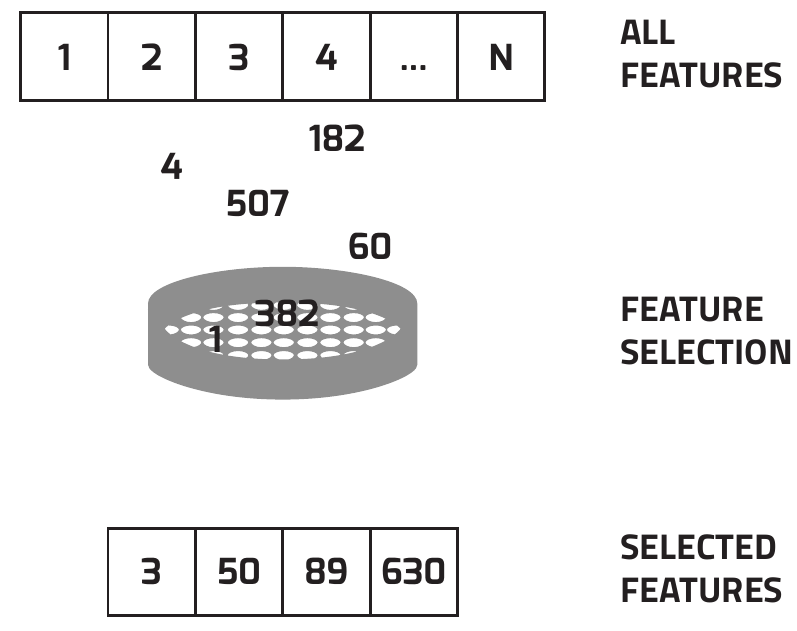
Figure 3. General Feature